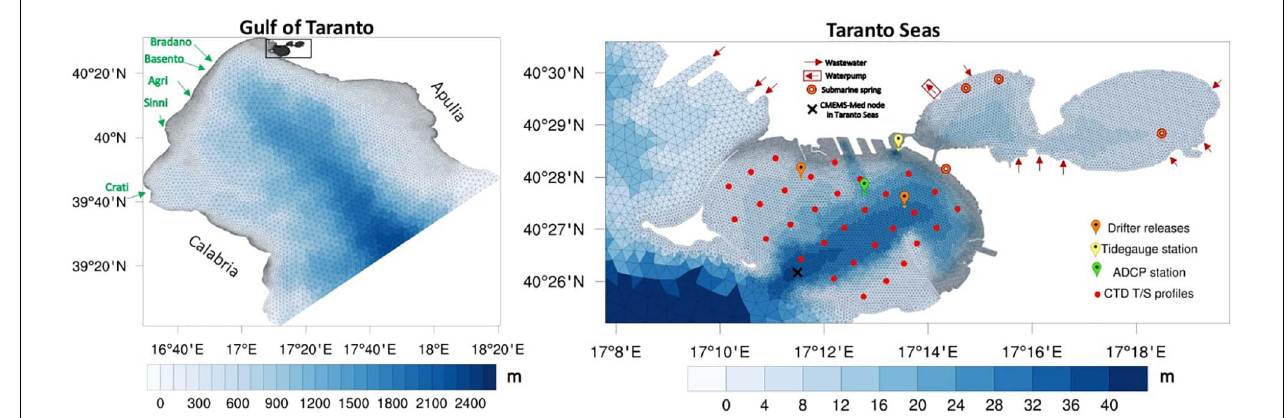
FIGURE 2 | Case study 1: SURF-U horizontal grid with bathymetry overlapped for ( left panel ) the whole domain (Gulf of Taranto) and for ( right panel ) Taranto Sea. Red, green, yellow, and orange dots denote the locations of the CTD, ADCP, tide-gauge data and drifter releases, respectively.